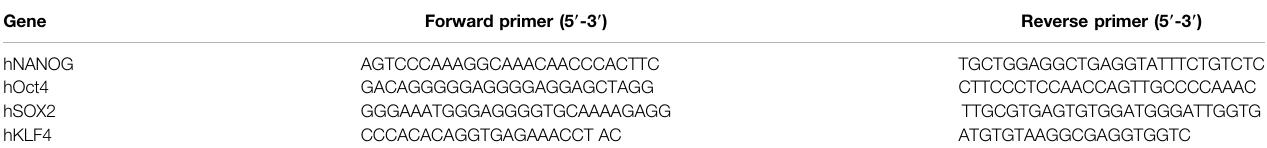
TABLE 1 | Primer sets used for PCR.